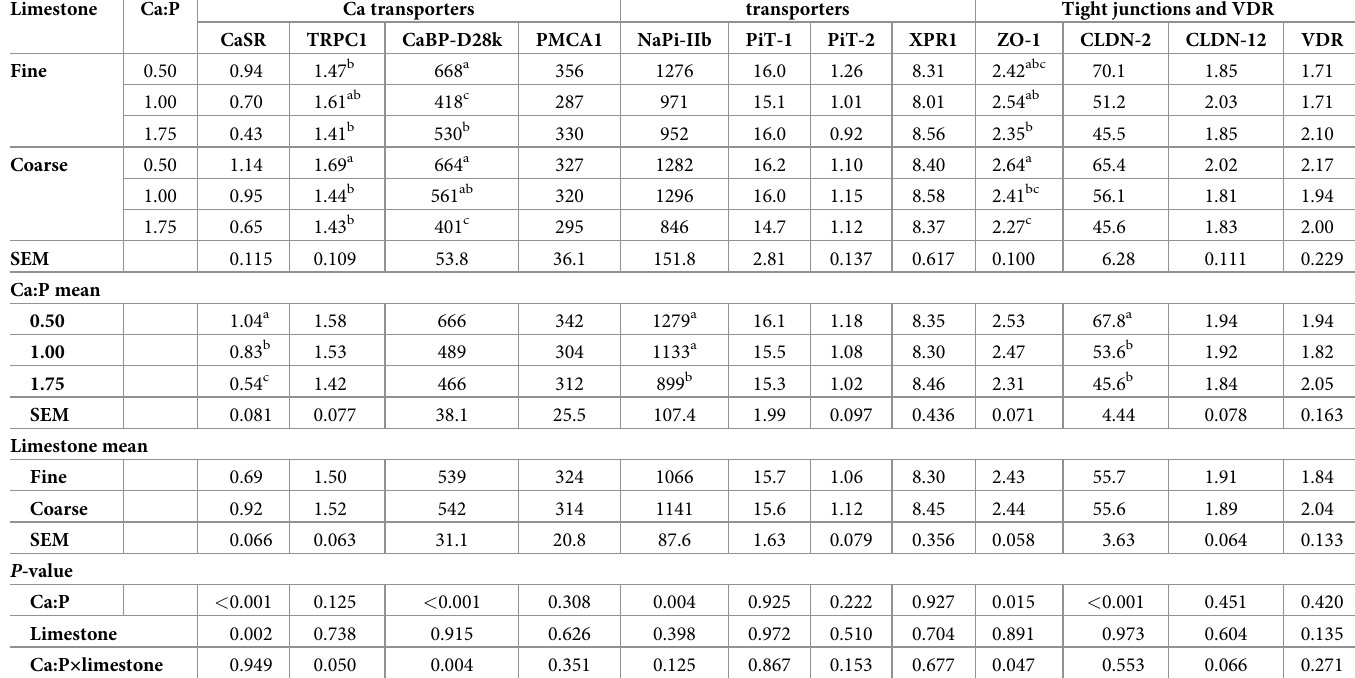
Table 3. Least square mean of mRNA expression levels of Ca and P transporters and claudins in the jejunal mucosa as affected by dietary total Ca: Total P ratio (Ca:P), limestone particle sizes and their interaction in broilers 1,2,3 . Limestone Ca:P